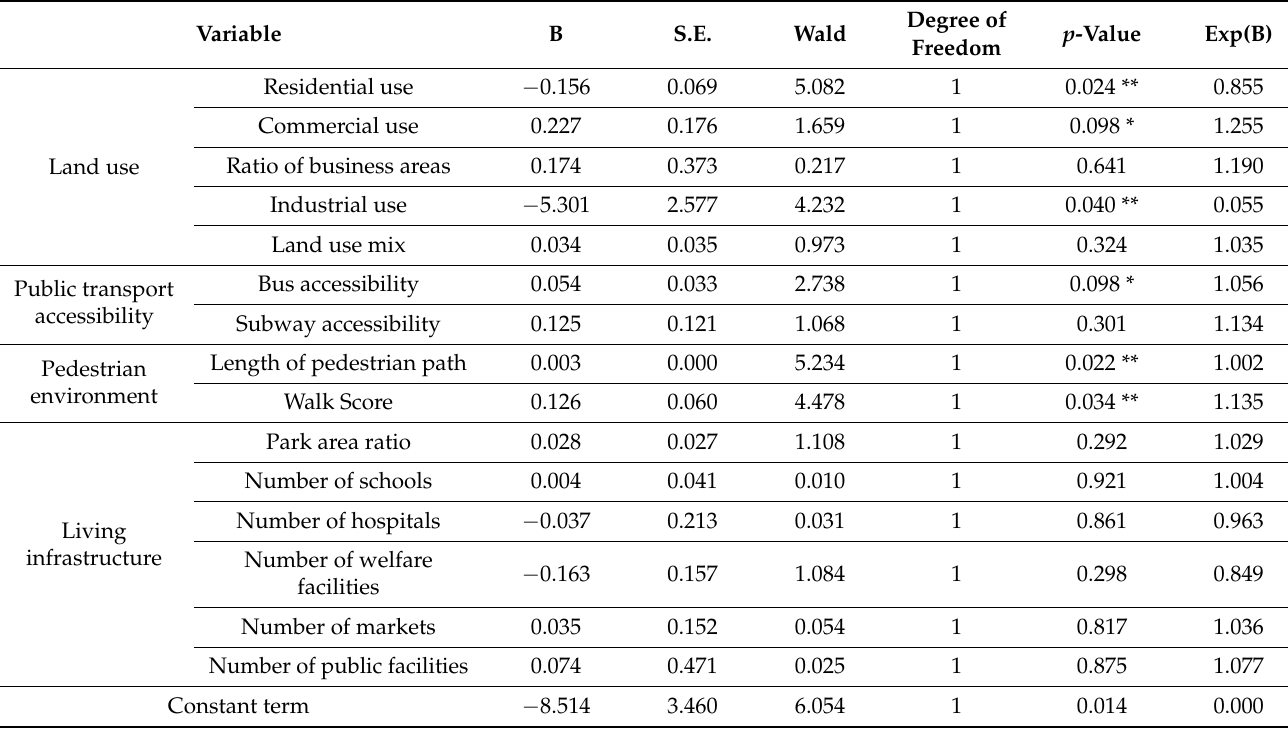
Table 6. Results of logistic regression analysis